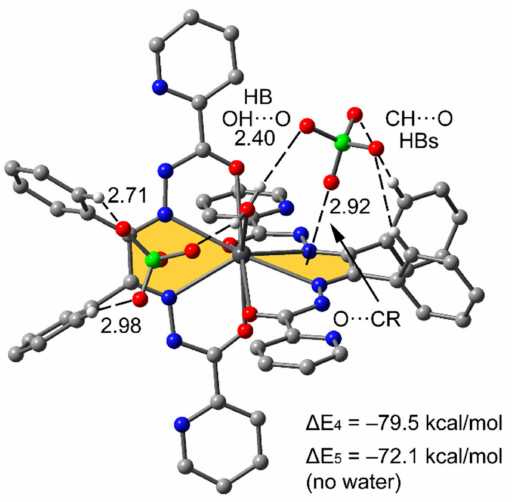
Figure 12. Theoretical model of compound ( 3 ) (distances in Å). H-atoms omitted for clarity apart from those participating in